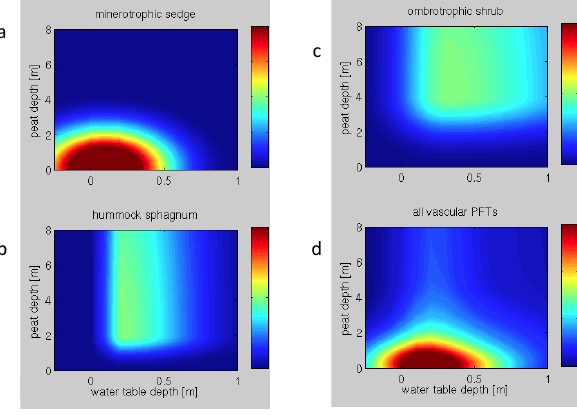
Fig. 2. Relative annual NPP as a function of water table ( z WT , hor- izontal axis) and total peat height ( h PD , vertical axis) as a proxy for ombrotrophy for (a) minerotrophic sedge PFT, (b) hummock Sphagnum PFT, (c) ombrotrophic shrub PFT, and (d) sum of all 12PFTs. See Eq. (6) for the functional form and Table 1 for the parameter values for all 12PFTs. Note that for vascular PFTs, the water table depth used is the mean of the current and past 10 years, while for bryophytes the current year water table depth is used. Color bar is linear in all panels, but represents a relative scale from low (dark blue) to high (dark red). NPP for all PFTs is scaled by a single value so that the maximum NPP in panel (d) equals a site- specific prescribed value. Each year the developing peatland has particular values for z WT and h PD , which determine NPP for each PFT. All NPP is deposited as litter (i.e., no live biomass accumu- lation), and vascular PFT NPP is partitioned into above and below- ground fractions (see Table 1 and text for